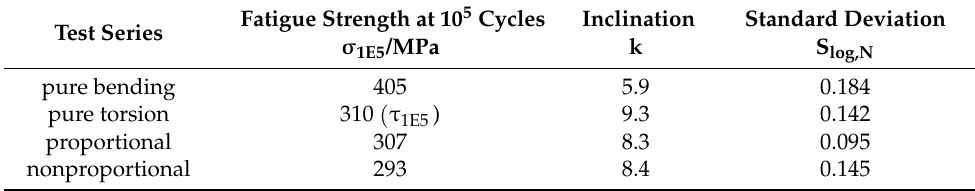
Table A5. Parameters describing the S–N curve.